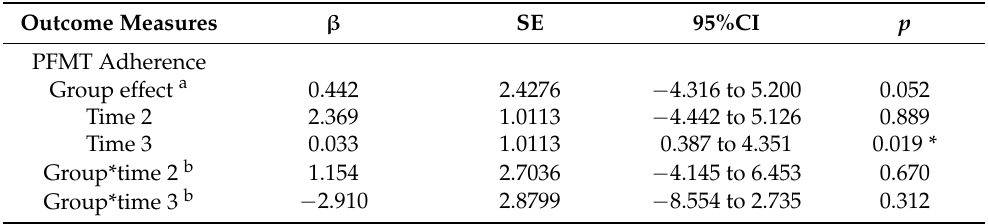
Table 5. The effect of KEPT app on pelvic floor muscle training